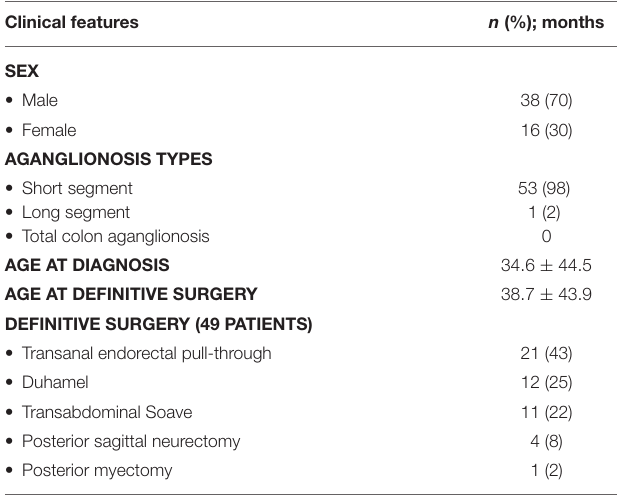
TABLE 1 | Clinical features of the HSCR patients for SEMA3D sequencing analysis. Clinical